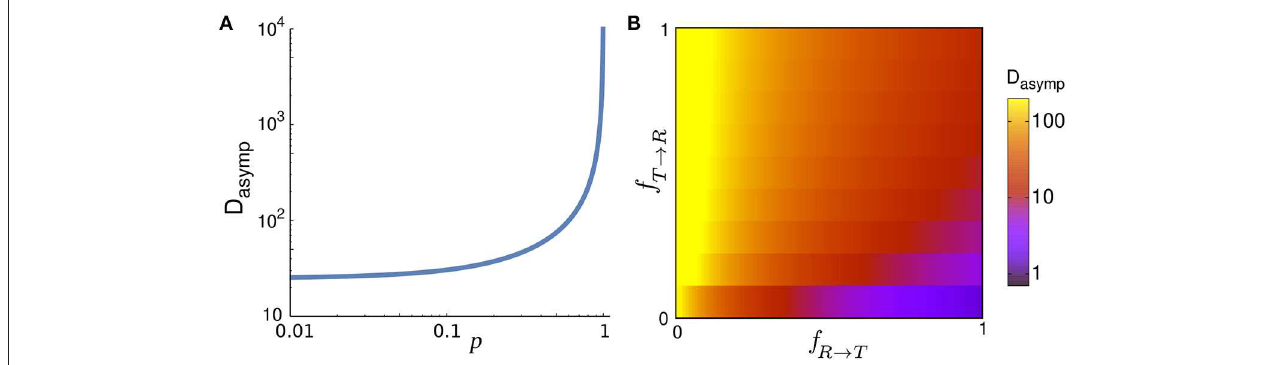
= 0.001, and f = 0.9. (B) D asymp in the R → T T → R